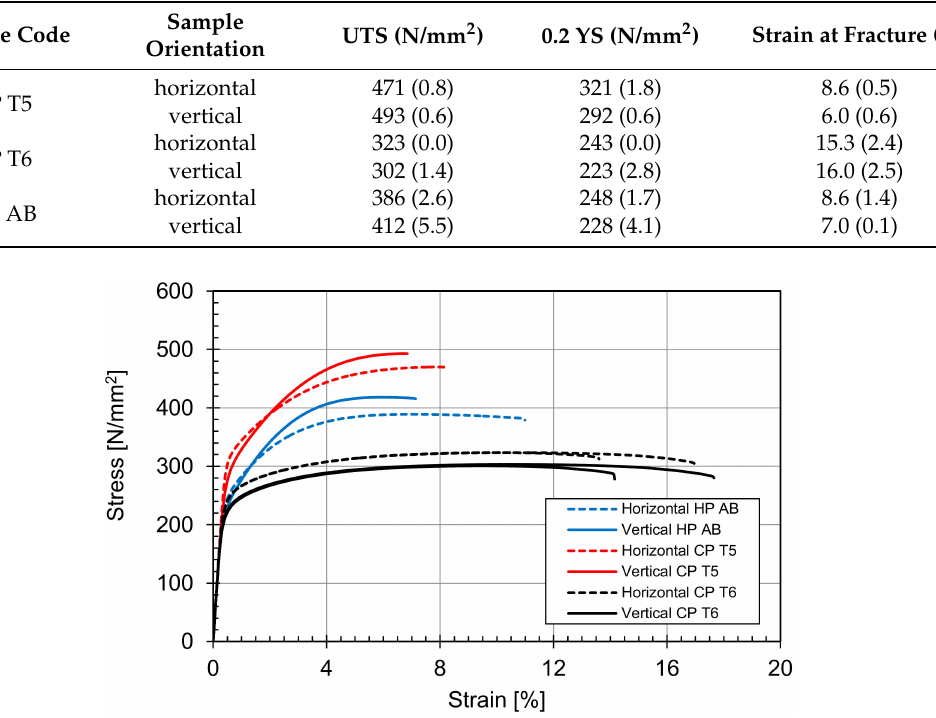
Table 4. Average tensile data (UTS: ultimate tensile strength; YS: yield strength) of the SLM-processed AlSi10Mg alloy heat-treated to the different tempers. Standard deviation is given in brackets.